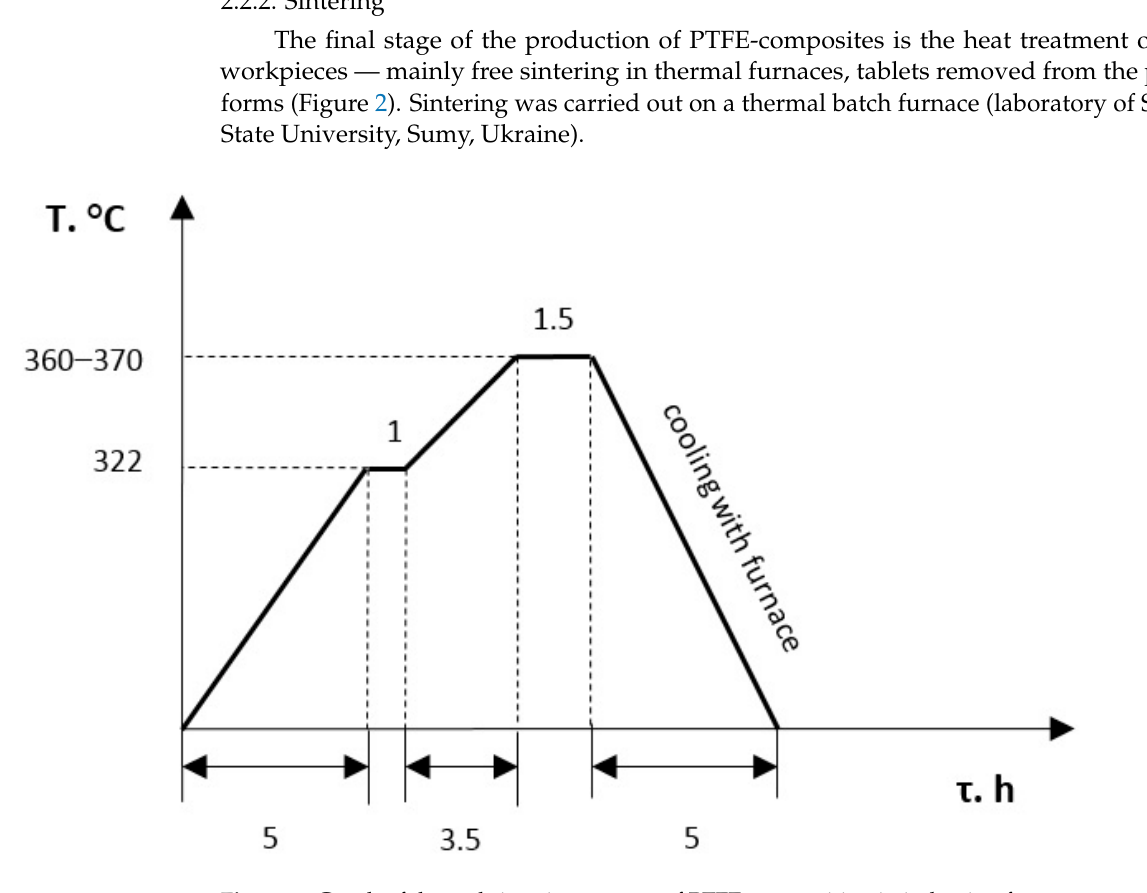
Figure 2. Graph of the real sintering process of PTFE-composition in induction furnace.